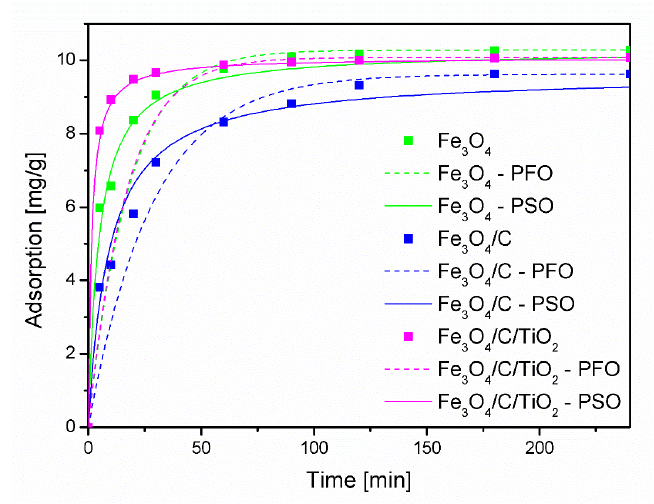
Figure 6. Kinetics of arsenate adsorption for an initial addition of 10 mg As/g adsorbent at 25 °C and pH 2.